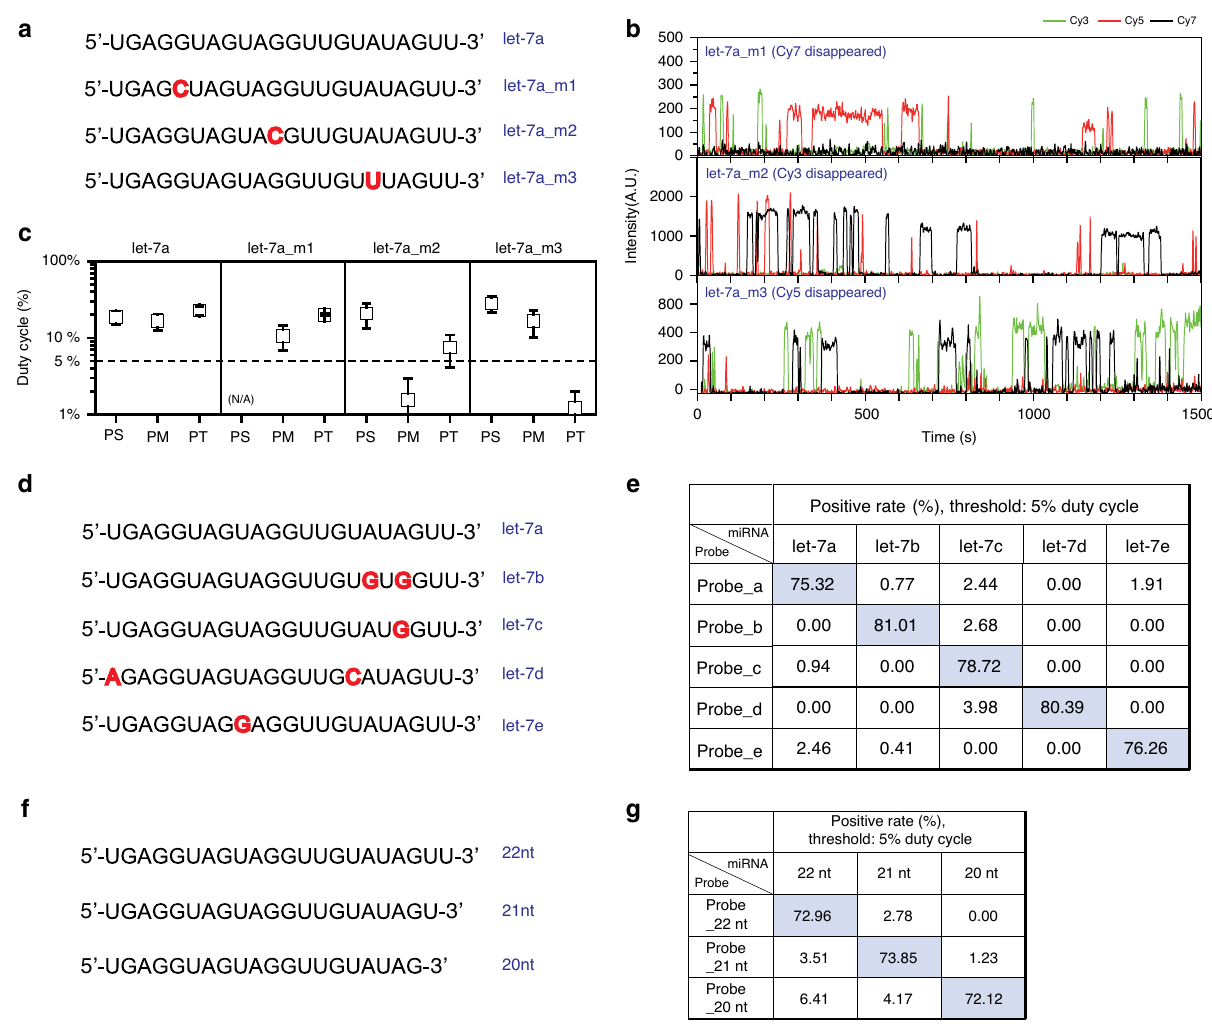
Fig. 2 miRNA sensing with high speci fi city for the whole region of miRNA. a Sequences of let-7a and its single-nucleotide mutations (red) at seed, mid, and tail regions. b Representative fl uorescence intensity time traces showing binding of let-7a probes to let-7a_m1 (top), let-7a_m2 (middle), and let- 7a_m3 (bottom), respectively. c Duty cycles of let-7a probes on wild-type let-7a and its mutants. d The sequences of let-7 family miRNAs. e Positive rates (either true: diagonal, or false: off-diagonal) of let-7 family miRNAs measured using Ago-FISIH. f The sequences of let-7 miRNAs with varying U-tail length. g Positive rates (either true: diagonal, or false: off-diagonal) of let-7 miRNAs with varying U-tail length measured using Ago-FISH. To obtain each data point of c , e , and g , three or more independent experiments were conducted and at least 300 molecules in total were analyzed. The criteria of 5% duty cycle was used to make the tables. Data are mean ± SEM. For all statistical analyses of miRNA detection in this work, 20 min imaging time was used. Source data are available in the Source data fi